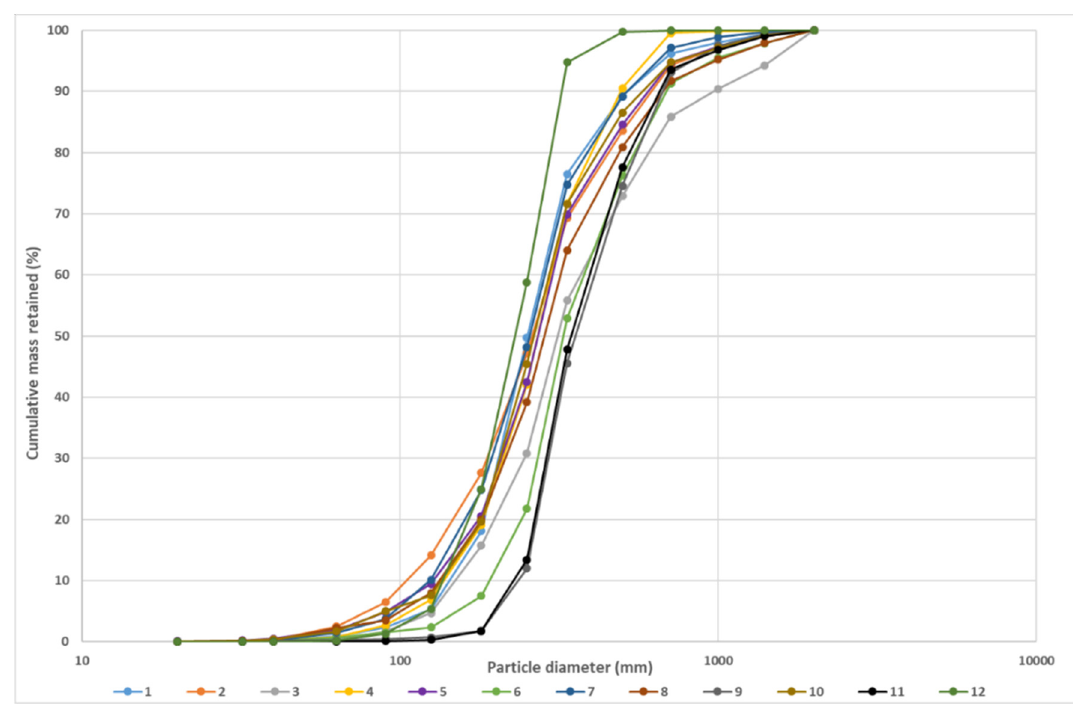
Figure 4. Cumulative grain size distribution of samples on a logarithmic scale. Numbering according to sites in Figure 3. Table 3. Statistical parameters of the grain size distribution of collected samples according to Folk and Ward [24].